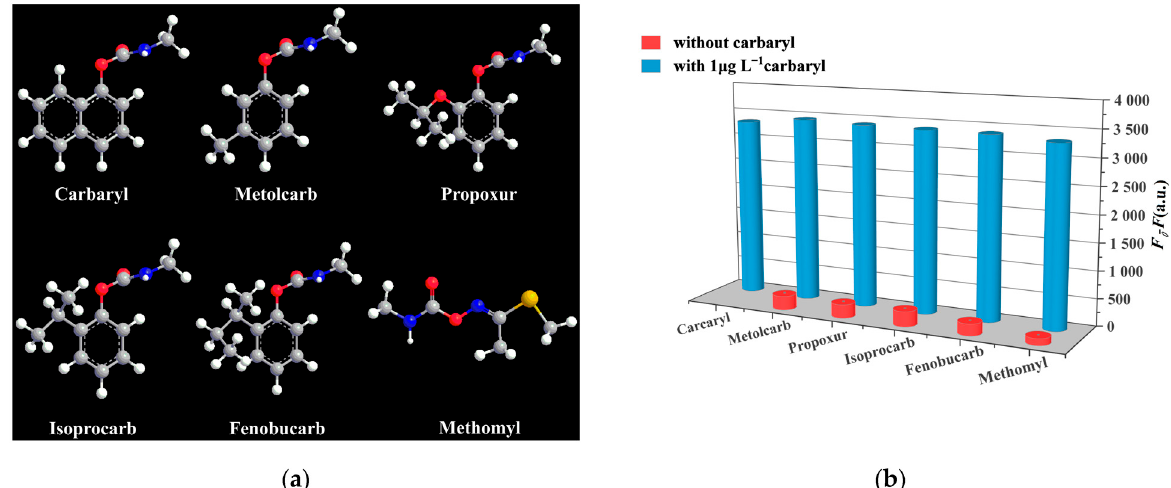
Figure 4. ( a ) The chemical structure of carbaryl and its structural analogs; ( b ) the selectivity of the Eu 3+ -MOF-253@Au/GCE towards carbaryl and interferents.